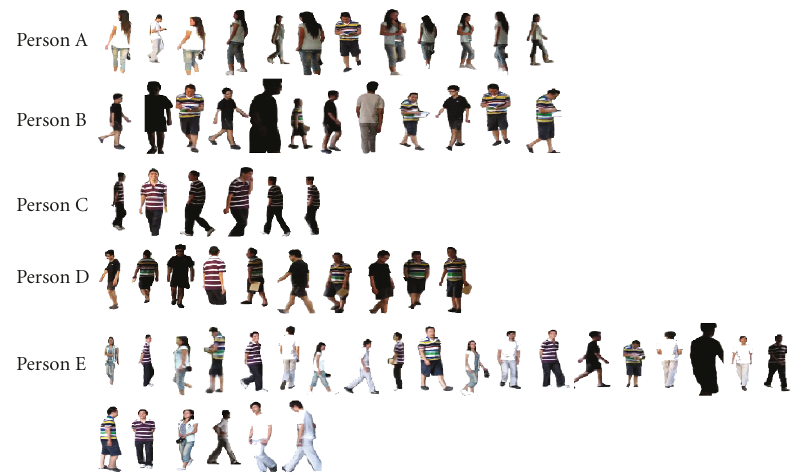
Figure 16: Trajectories recovered by standard EM initialized by K-means clustering.